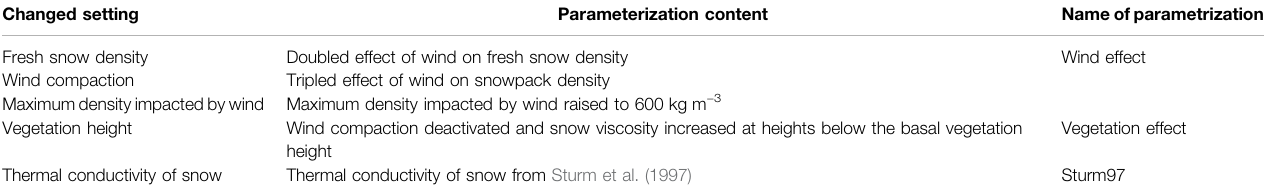
TABLE 3 | Summary of modi fi ed parametrizations in the “ Arctic Crocus ” (AC)